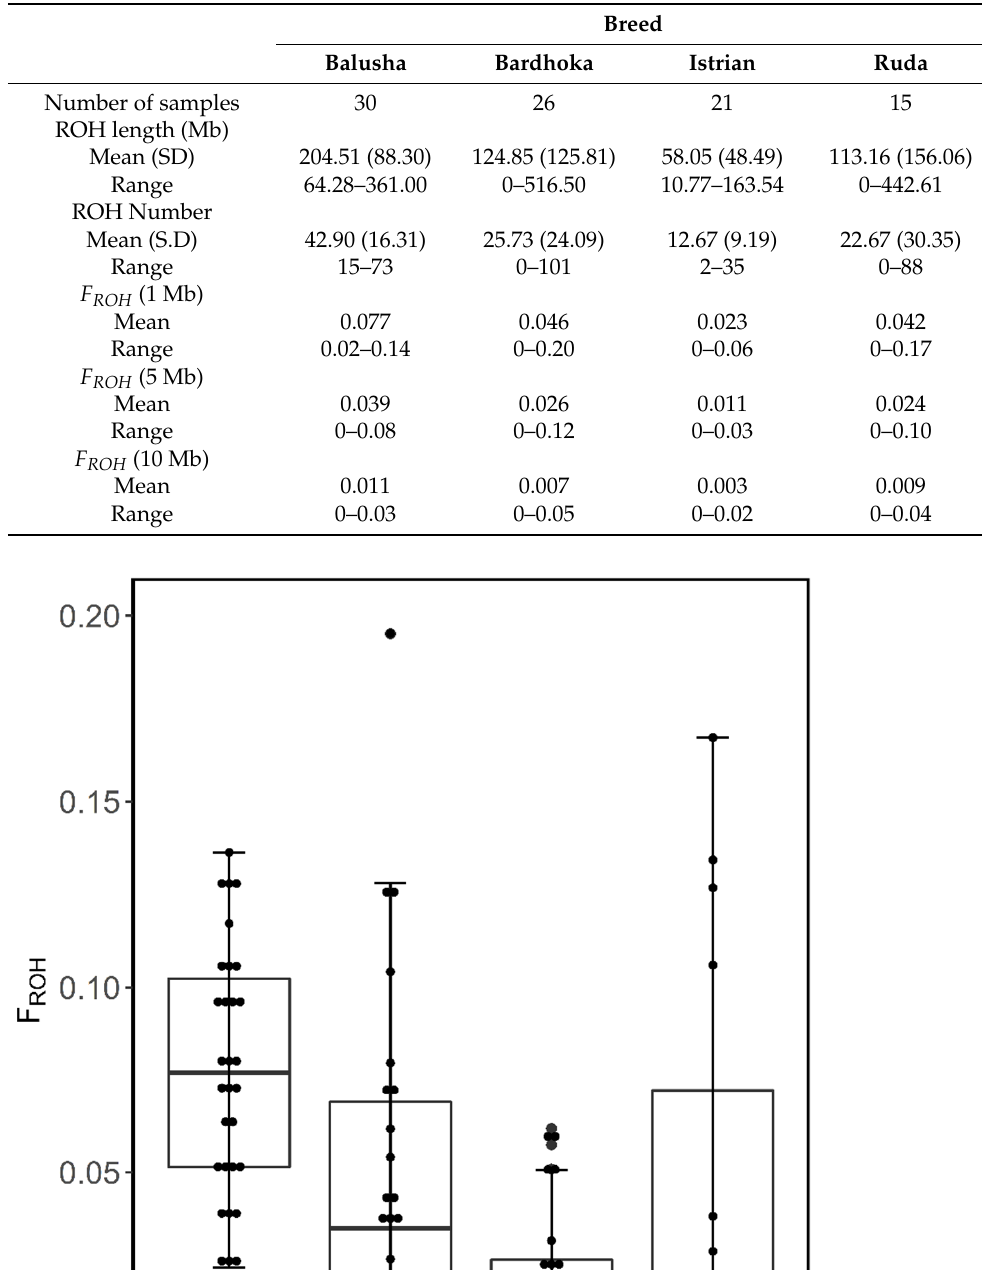
Table 2. Descriptive statistics for ROH and FROH of breeds analyzed in this study.